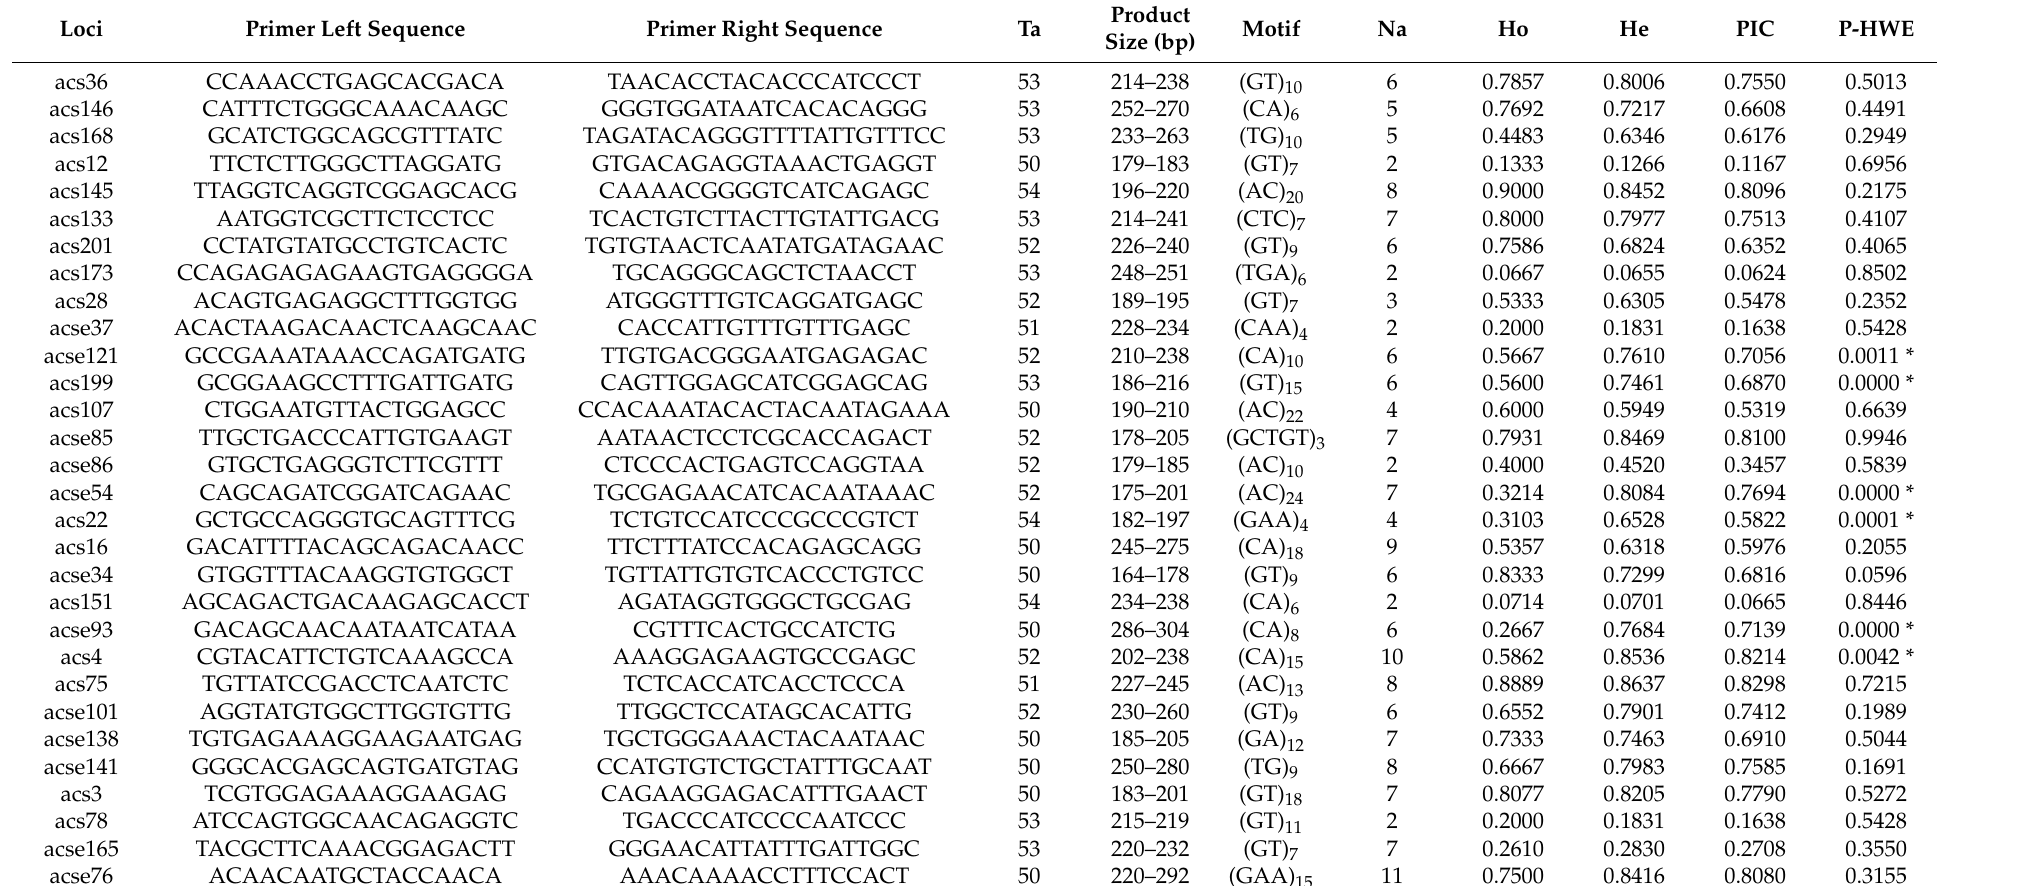
Table 2. Characterization of 51 polymorphic microsatellite markers of blackhead